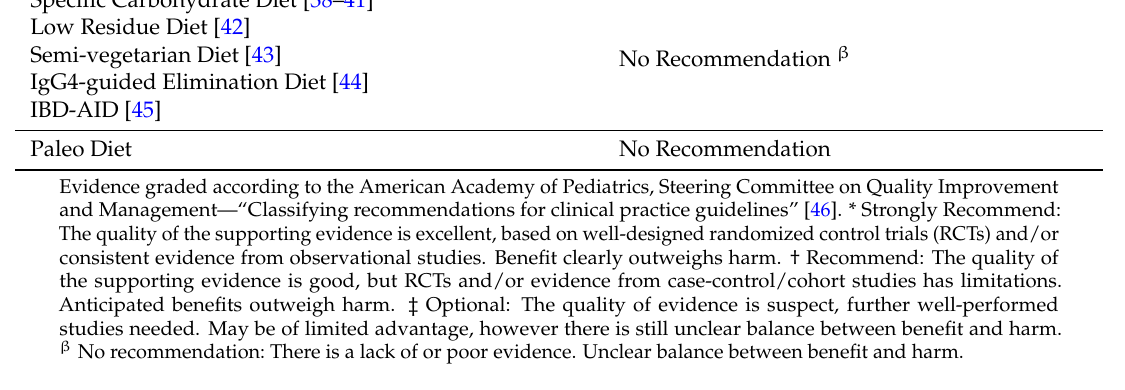
Table 2. Evidence-based nutrition recommendations for supplements in the maintenance of remission in